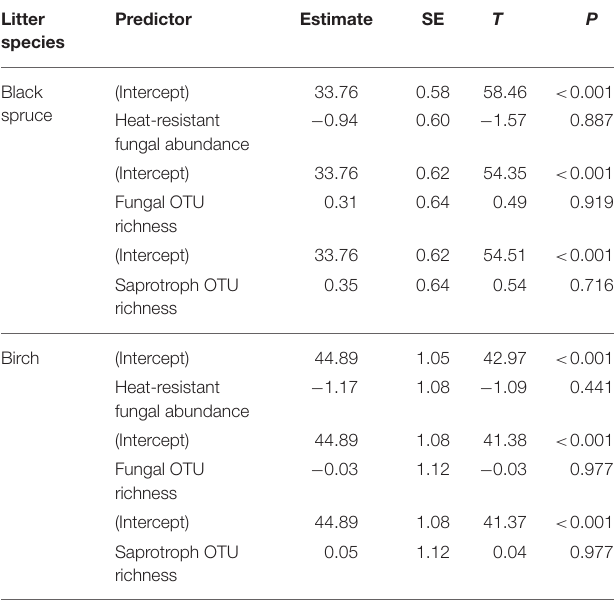
TABLE 3 | Summary of linear models of plot-level in situ litter decomposition against predictors of fungal community structure: heat-resistant fungal relative abundance, fungal operational taxonomic unit (OTU) richness, and saprotroph OTU richness, based on high throughput sequencing at 17 plots in burned boreal forests, Northwest Territories,